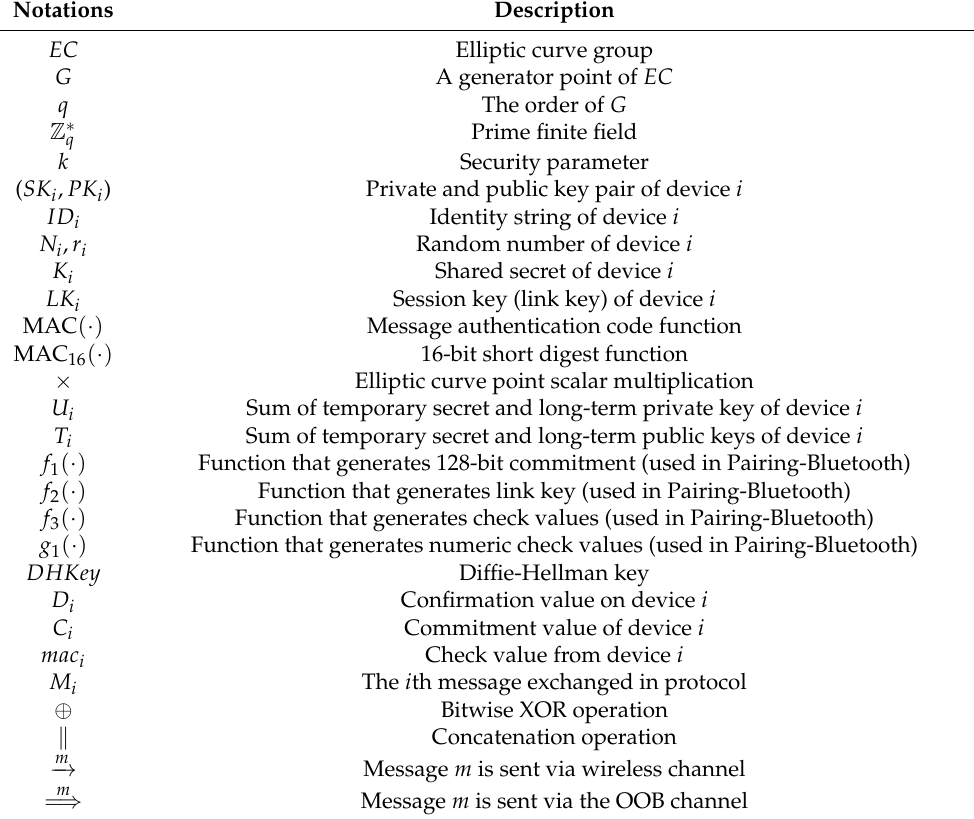
Table 1. Notations and corresponding